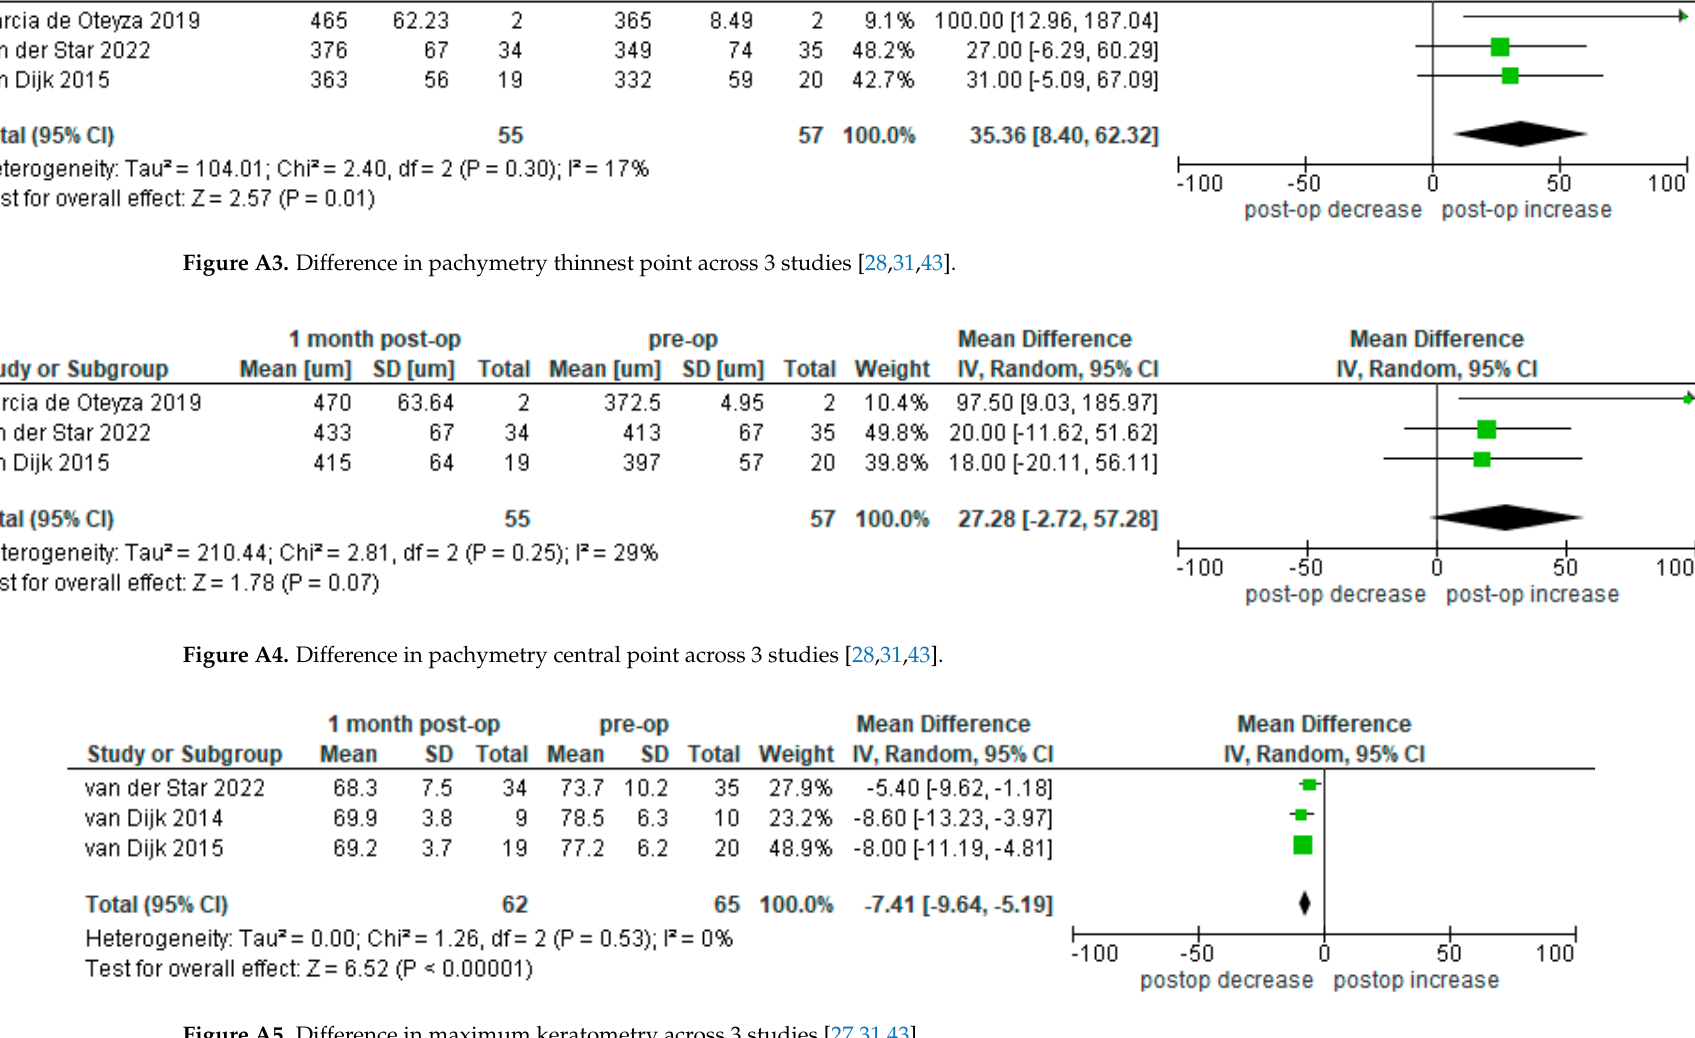
Figure A6. Di ff erence in mean simulated keratometry across 3 studies [27,31,43].